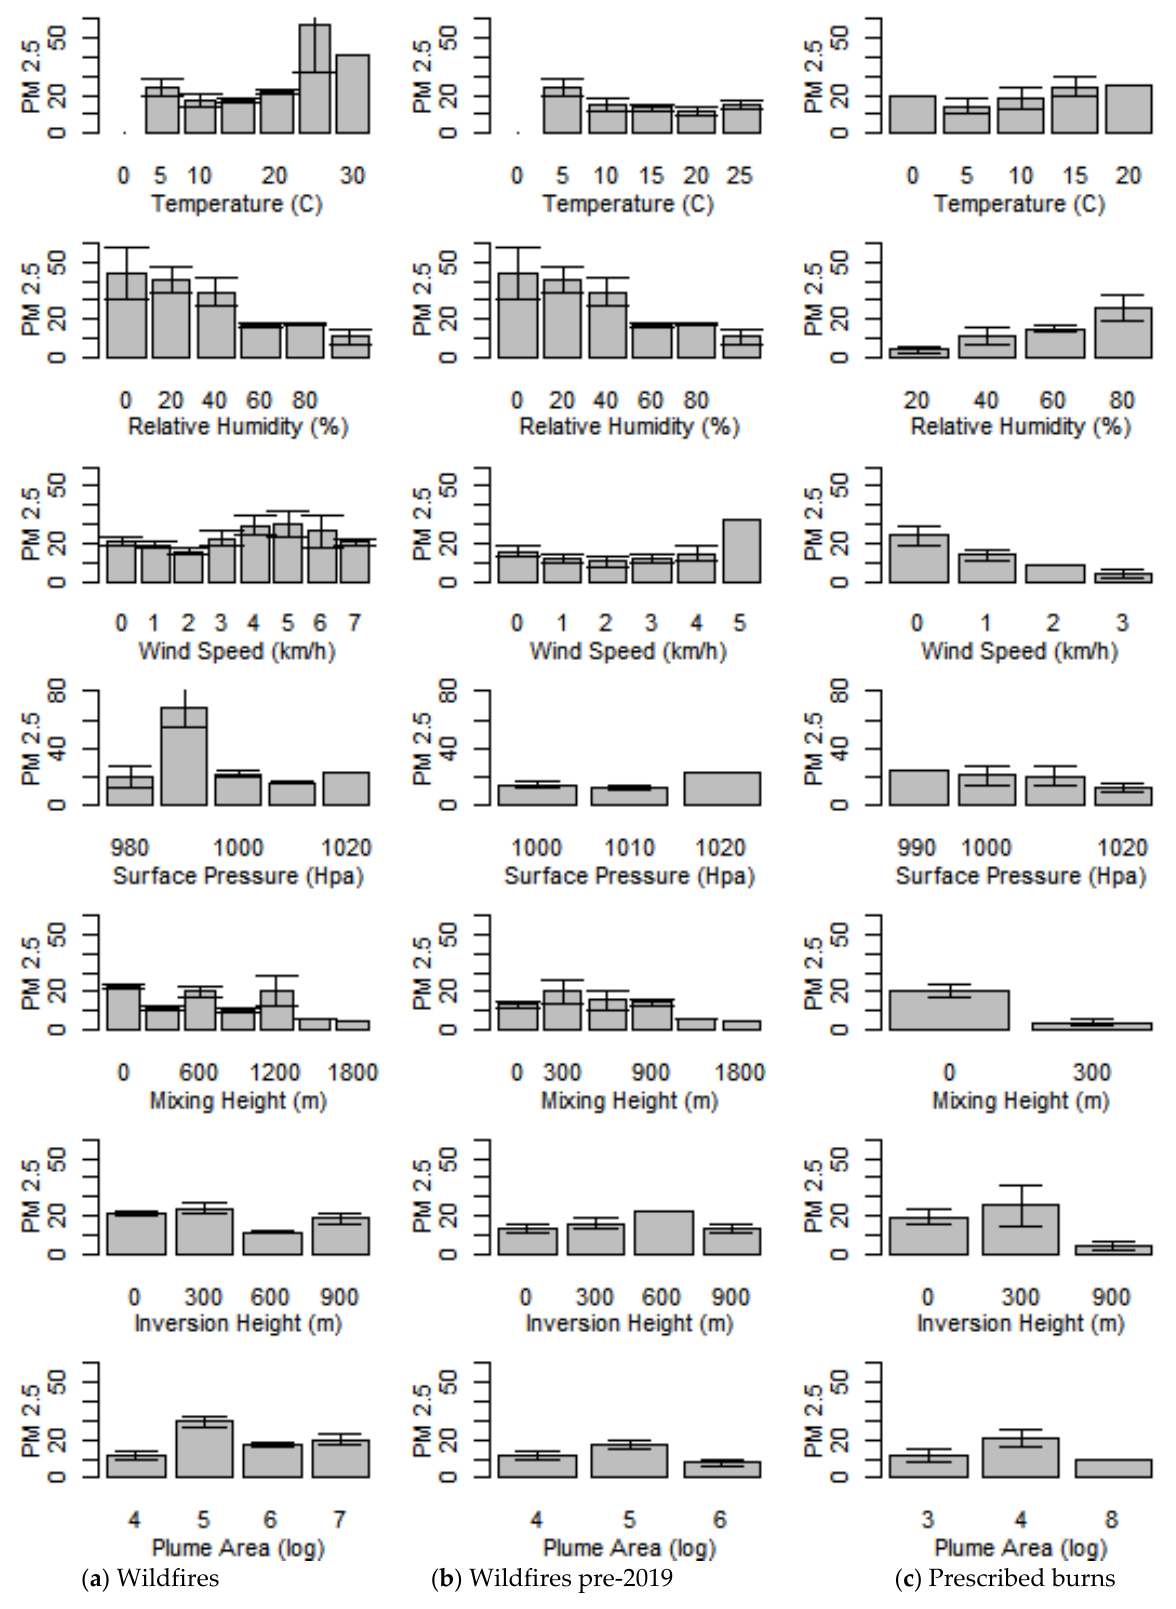
Figure 6. Relationship between night-time PM2.5 values and predictor variables for ( a ) Wildfire plumes, ( b ) Wildfire plumes excluding the 2019-20 season, and ( c ) Prescribed burn plumes.